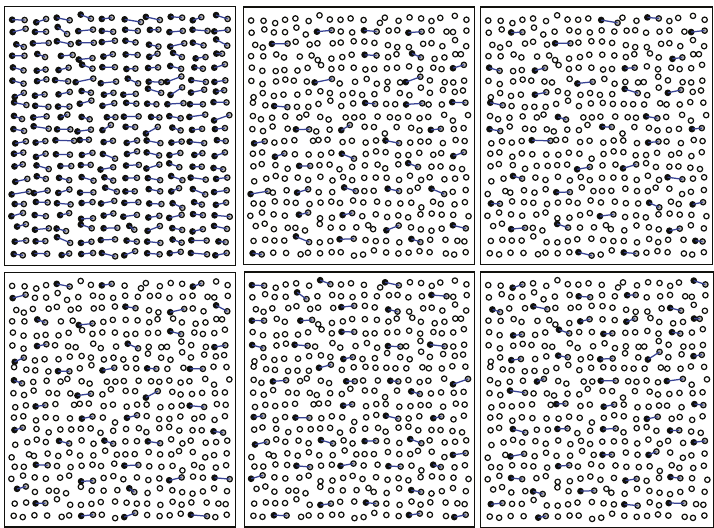
Figure 6: A quasiregular network of 200 links (upper left) is partitioned by the DCLS algorithm with K = 5 and λ = 40 into five subnetworks where the black circles represent the transmitting nodes and the grey circles the receiving nodes.